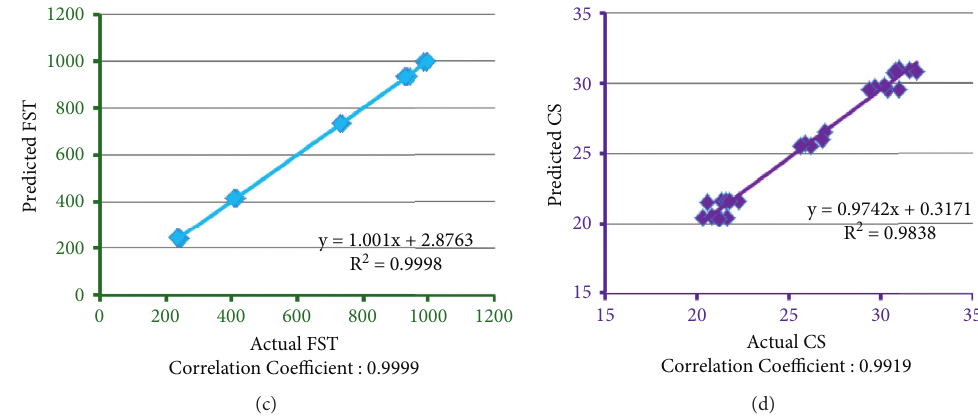
Figure 4: Physical properties of PPC for RHA as a replacement. (a) Standard consistency; (b) initial setting time; (c) final setting time; (d) compressive strength of